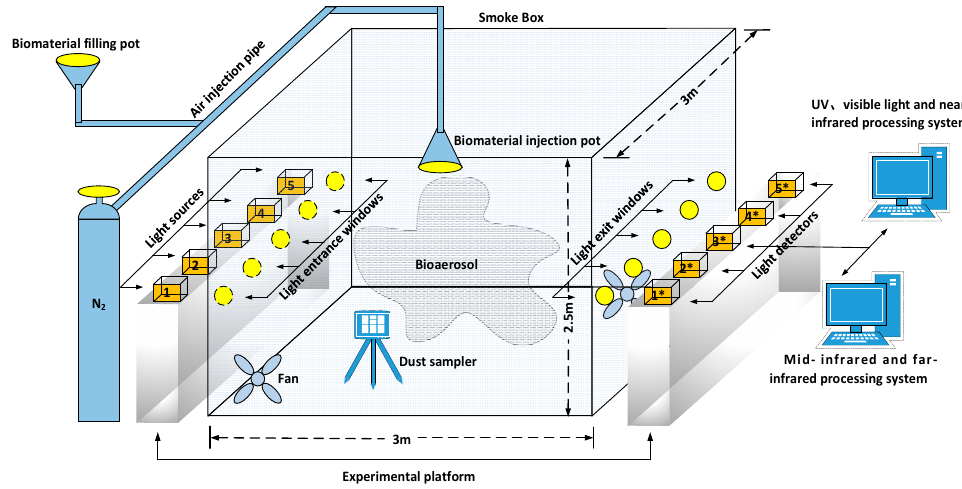
Figure 6. Broadband extinction performance test system for bioaerosols.